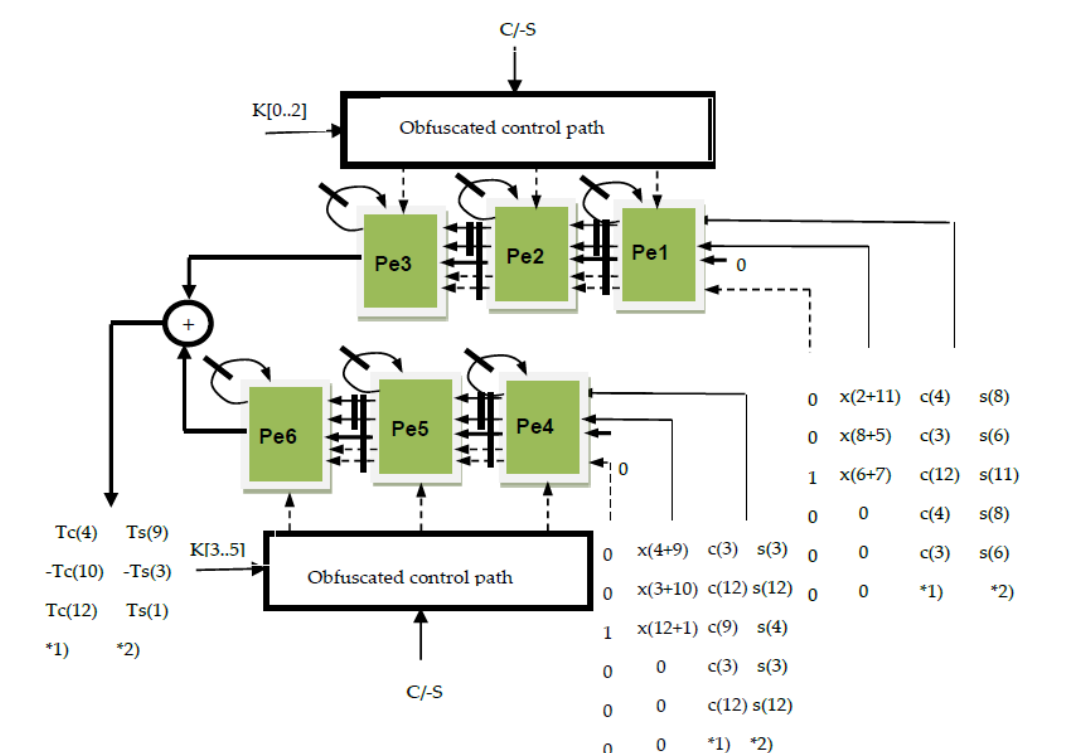
Figure 14. The unified VLSI architecture for DCT/DST-IV based on the unified algorithm for Equations (10) and (33) where *1) represents the cosine entry that is in parallel with *2) the sine entry; the correct entry is selected depending on the pre-processing stage to calculate what is needed (DCT-IV or DST-IV).